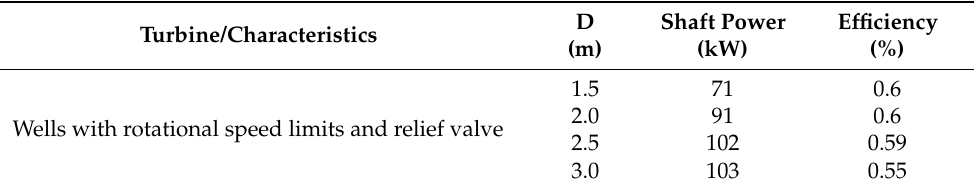
Table 2. Average Wells turbine shaft power vs. different diameters (D in m).